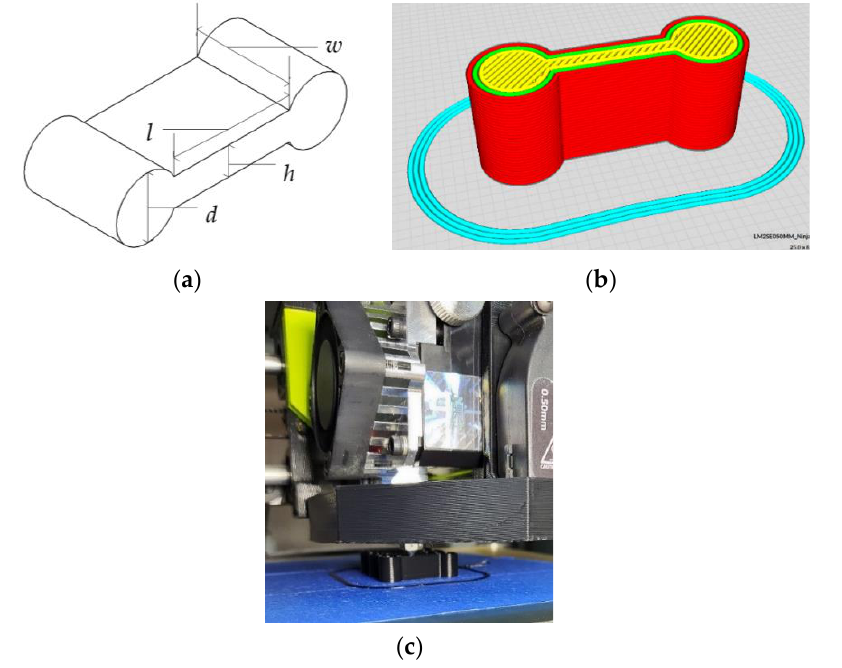
Figure 1. Specimen preparation: ( a ) variables of the specimens; ( b ) a specimen representation in the Cura Lulzbot ® Edition software; ( c ) printing a specimen using the LulzBot Taz Mini 2 ®